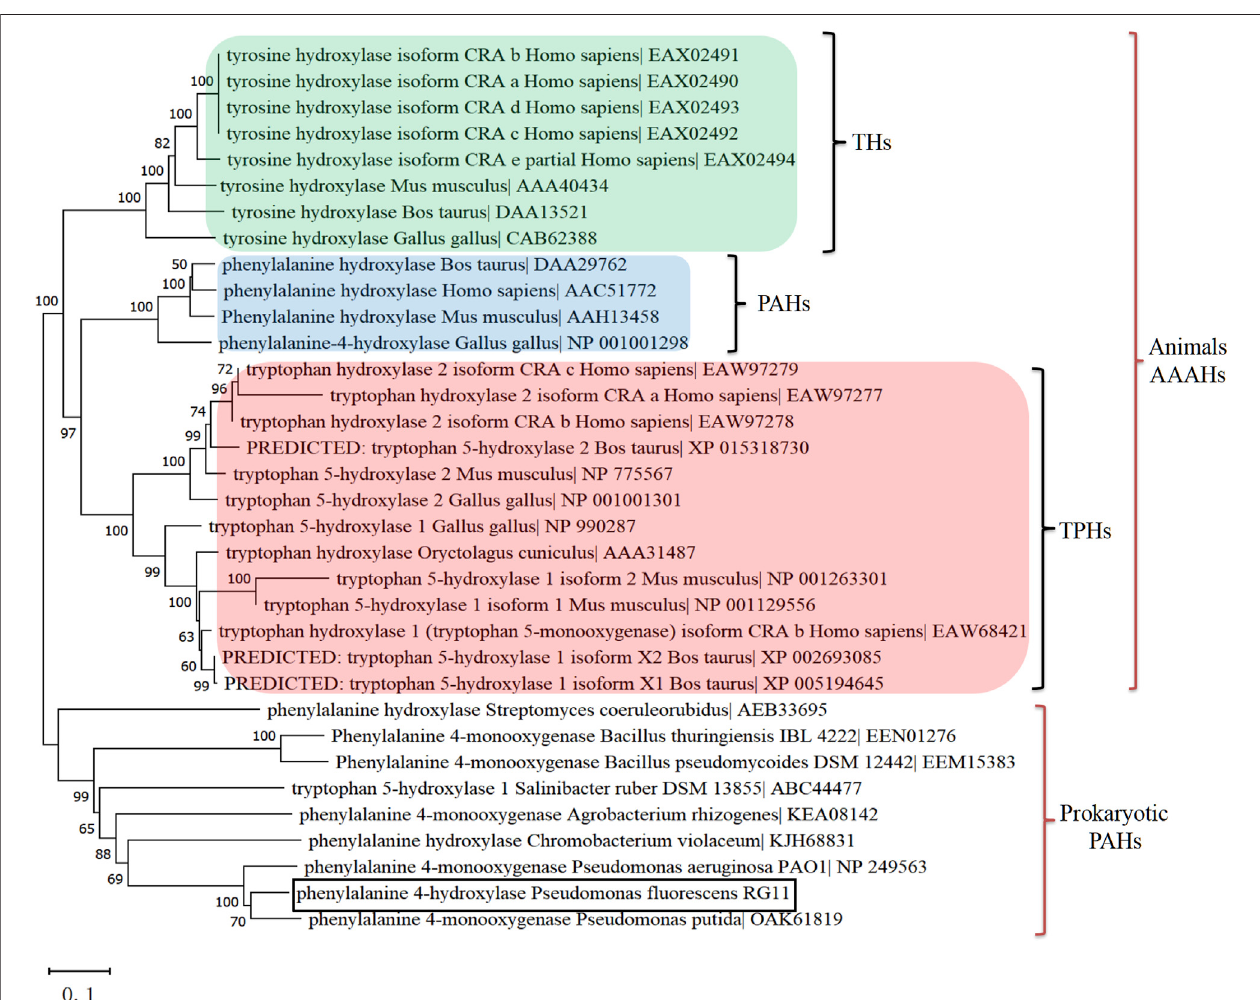
FIGURE2| RootedphylogenetictreebasedonprokaryoticPAHsandanimalAAAHs.Aneighbor-joiningtreewasgeneratedusingMEGAversionXwithbootstrap values from 1,000 replications. The scale bar indicates genetic distance. All other parameters were the default values. TPHs, tryptophan 5-hydroxylases; PAHs, phenylalanine 4-hydroxylases;THs, tyrosine 3-hydroxylases;AAAHs, aromatic amino acidhydroxylases. AnimalAAAHs aredistinctlydivided intothree subgroups:THs (green), PAHs (blue), and TPHs